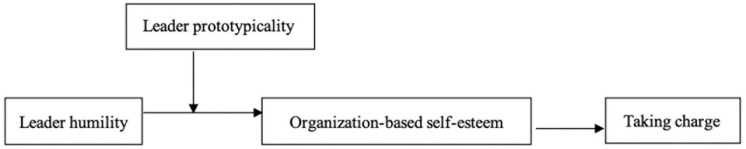
Theoretical model.